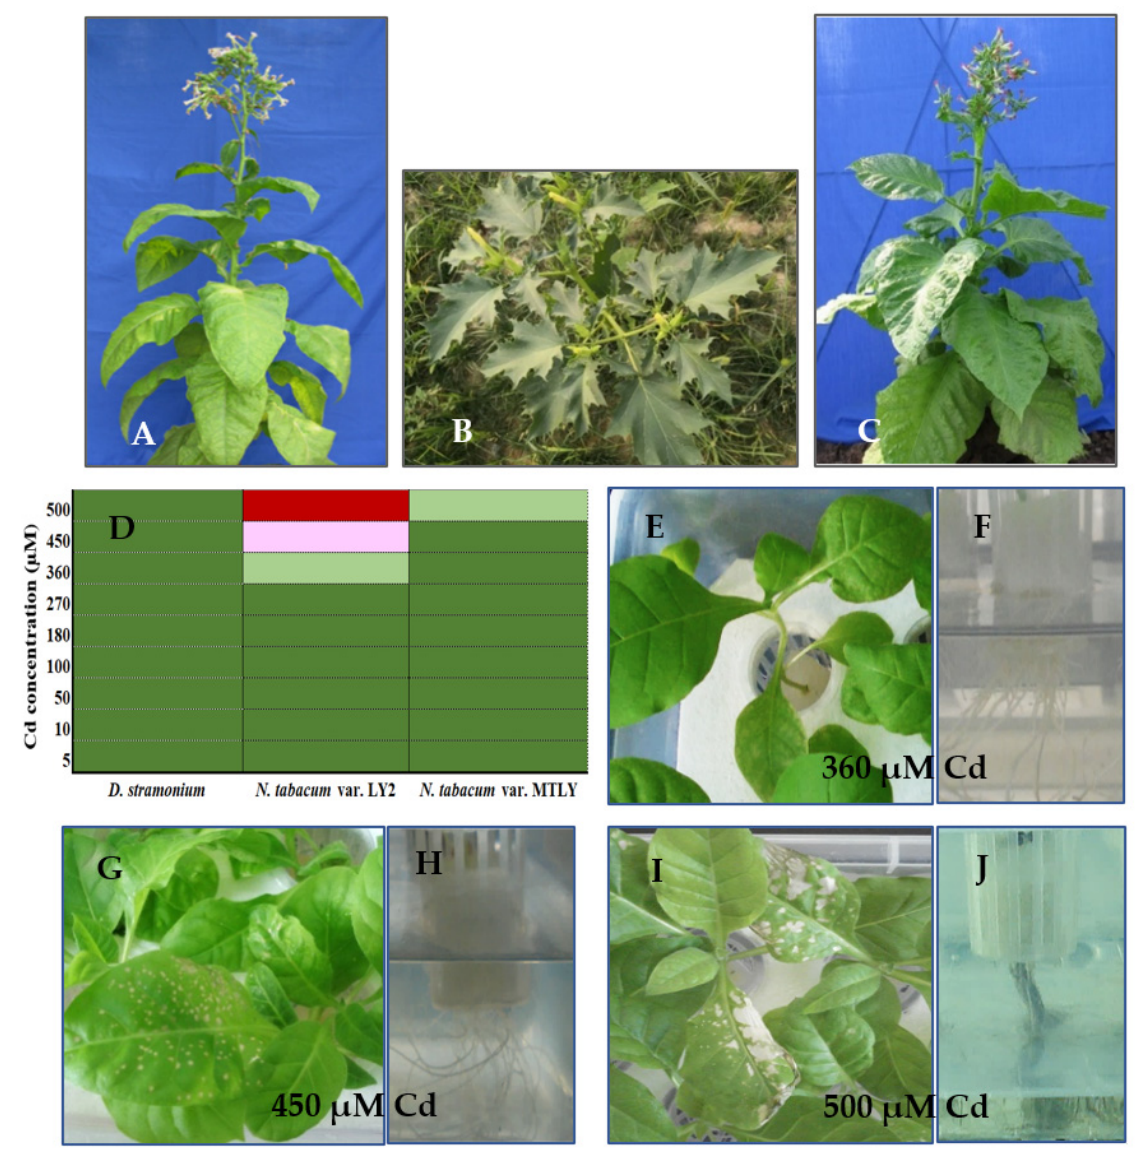
Figure 1. The plant materials and preliminary screening of Cd concentrations. ( A ) Nicotiana tabacum L. var. LY2 (pistillate parent). ( B ) Datura stramonium L. (pollen parent). ( C ) Nicotiana tabacum L. var. MTLY. ( D ) The toxic effects of different Cd concentrations (5–500 µ M) on 70-day old seedlings grown in hydroponics. The four colors, i.e., green, pale green, pink and red represented different severities, respectively. Observation showed that Cd tolerance of seedlings was in sequence: D. stramonium L. > N. tabacum L. var. MTLY > N. tabacum L. var. LY2. D. stramonium could grow even at 500 µ M Cd without visual and conspicuous symptoms. ( E – J ) When tobacco seedlings were exposed to 360, 450 and 500 µ M Cd, leaves and roots showed varying degrees of toxic symptoms, respectively. ( E , F ) Yellow spots on leaves, slight chlorosis of leaves and minor browning of root tips in N. tabacum L. var. LY2. ( G , H ) N. tabacum L. var. LY2 showed obvious phytotoxic symptoms, including leaf chlorosis and root browning. ( I , J ) Severe wilting and chlorosis in leaves and brown and necrosis in roots was found in N. tabacum L. var.